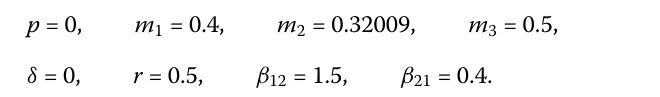
Set 3. To investigate the effect of commensalism on the coexistence of three species,